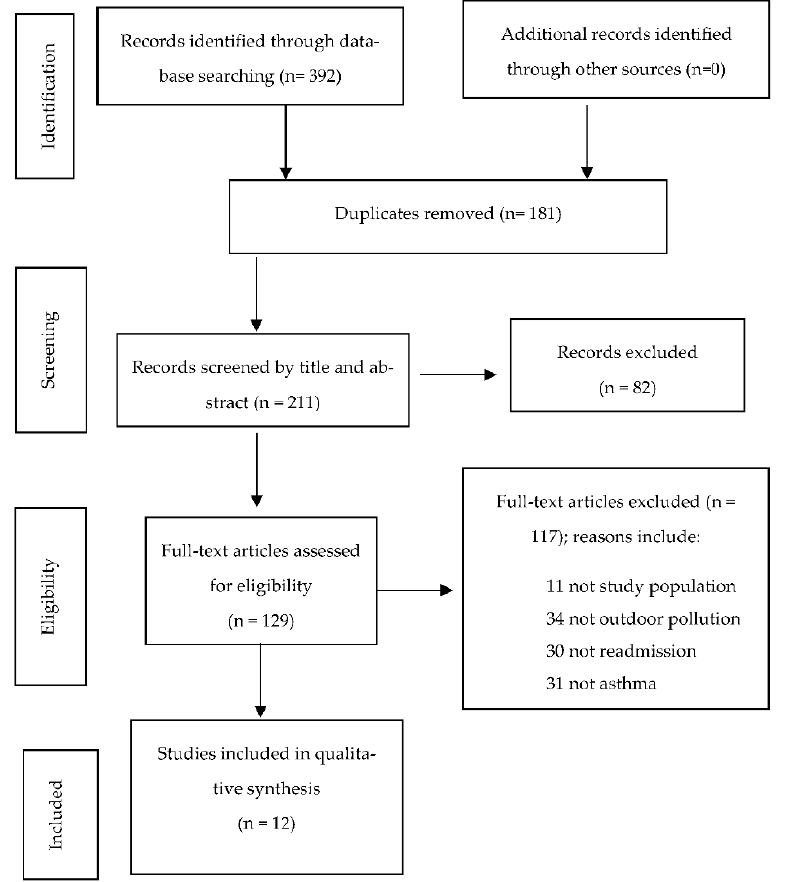
Figure 1. The flow diagram of the systematic review.